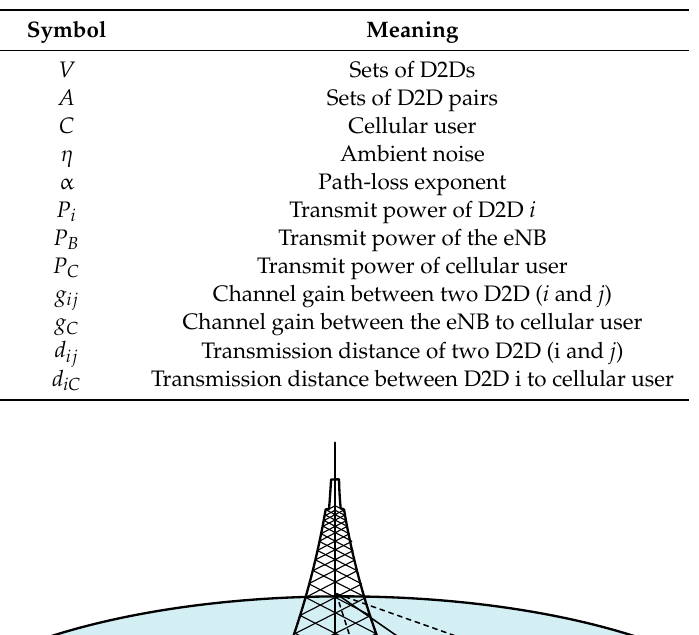
Table 1. Summary of notation.